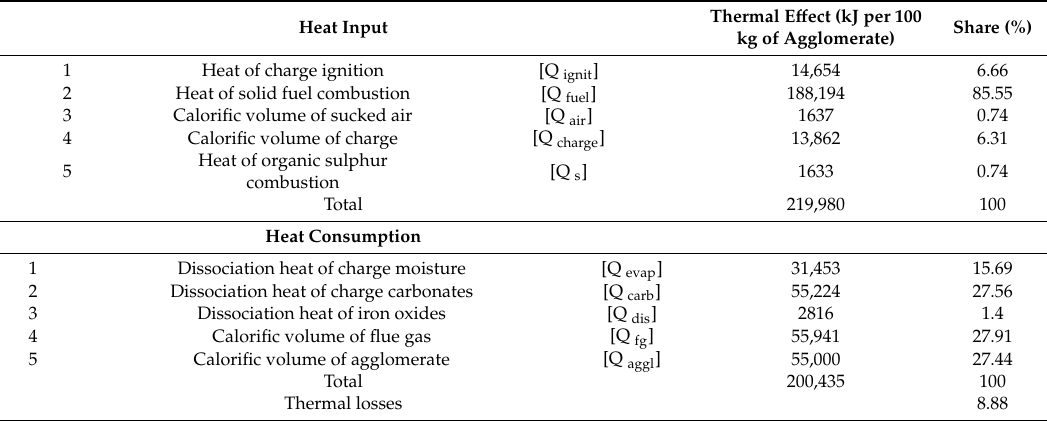
Table 1. Thermal balance of sintering process data from